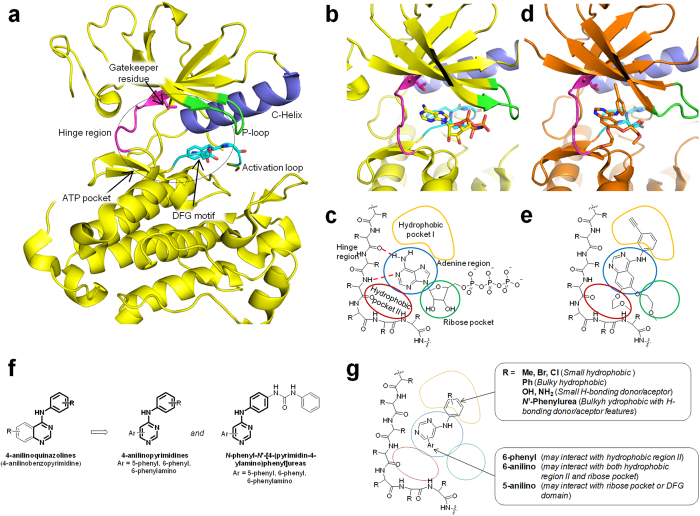
Structure of kinases and of designed compounds.(a) Main element in kinase structure. (b) Binding of AMP-ANP (PDB ID: 2GS7). (c) Schematic representation of binding of ATP and features of the ATP binding pocket. (d) Detail of binding of a kinase inhibitor (erlotinib; PDB ID: 1M17). (e) Schematic representation of binding of inhibitor (erlotinib) with respect to the features of the ATP binding pocket. Image partially readapted from ref. 22. (f) General structures of designed compounds and their structural relationship with 4-anilinoquinazolines. (g) Supposed binding mode of designed compounds in the ATP binding pocket.